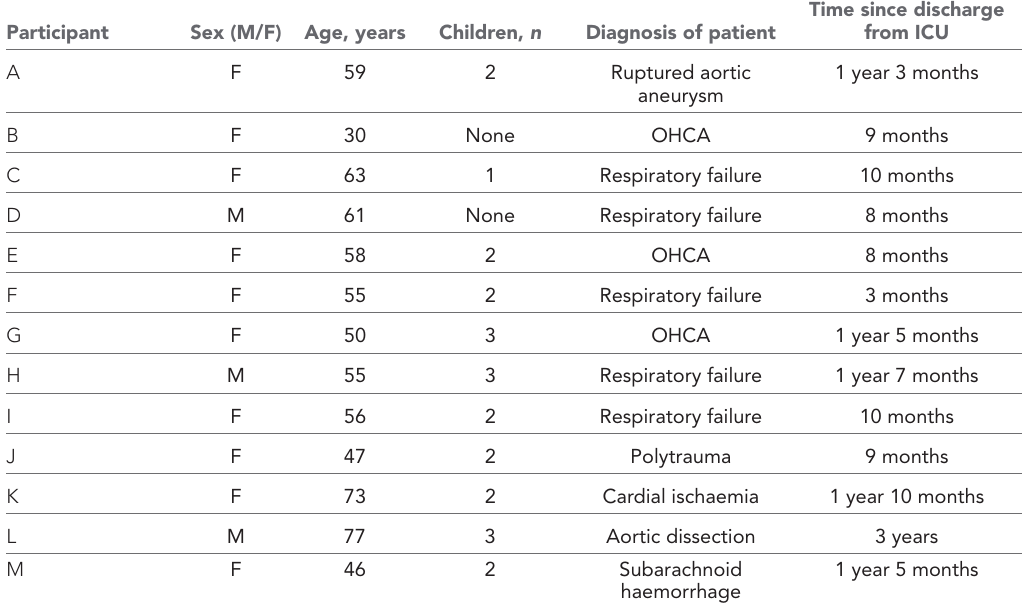
Table 1 Demographic characteristics of the